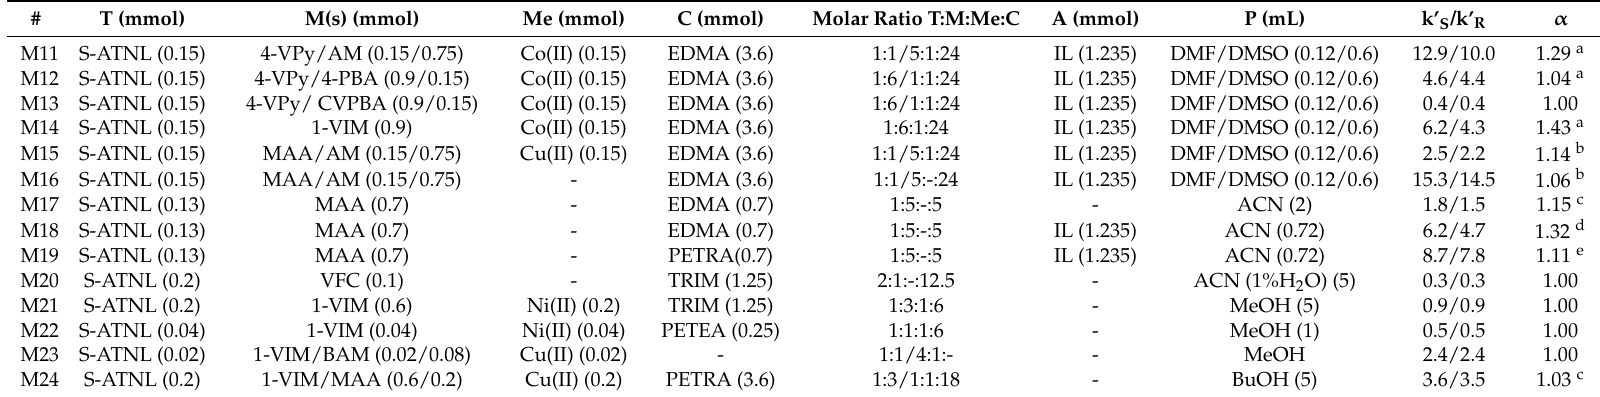
Table 3. Chromatographic retention (k’) and enantioselectivity ( α ) of various MIP-CSPs tested in monolithic columns with 4-VPy and various co-monomers (M11–13), or different functional monomers, other than 4-VPy